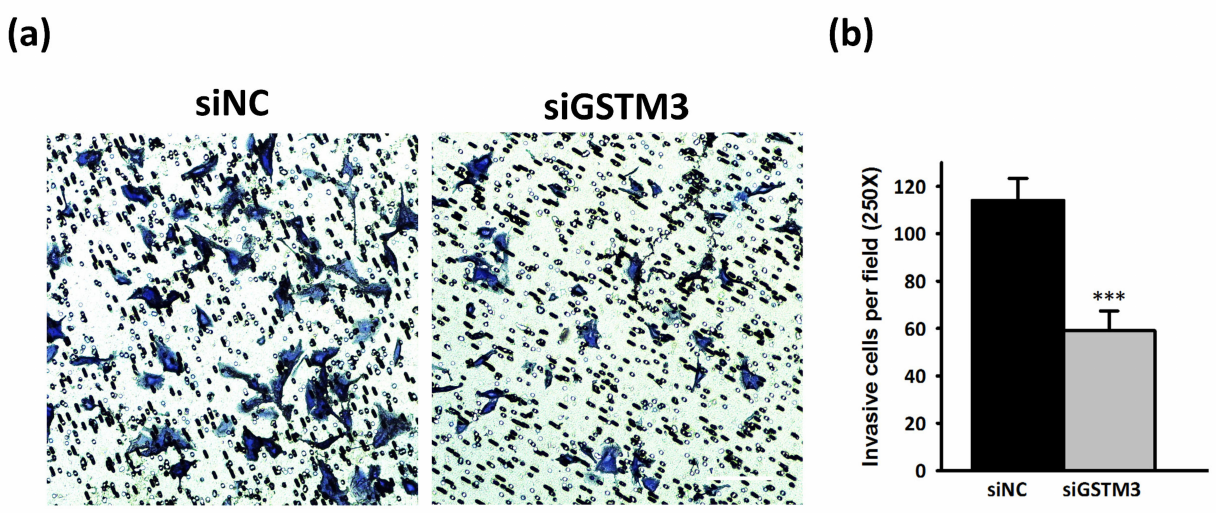
Figure 7. GSTM3 downregulation decreases the invasion ability of T98G glioblastoma cells. ( a ) Cell migration was measured using a collagen-I-coated Transwell chamber (8- µ m pore) for evaluating the migration of siNC and GSTM3 siRNA-treated cells. Migrated cells were stained with Giemsa solution (magnification 200 × ). ( b ) Cells on the underside of the Transwell insert were counted per file. Data are presented as mean ± SD ( n = 3). *** p < 0.001 relative to